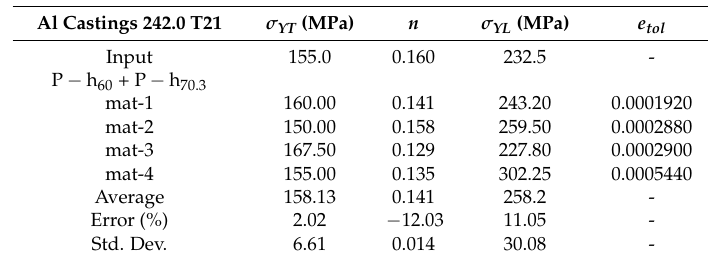
Table 4. Material parameters identified from inverse analysis using only the P-h curves in dual indentation tests.